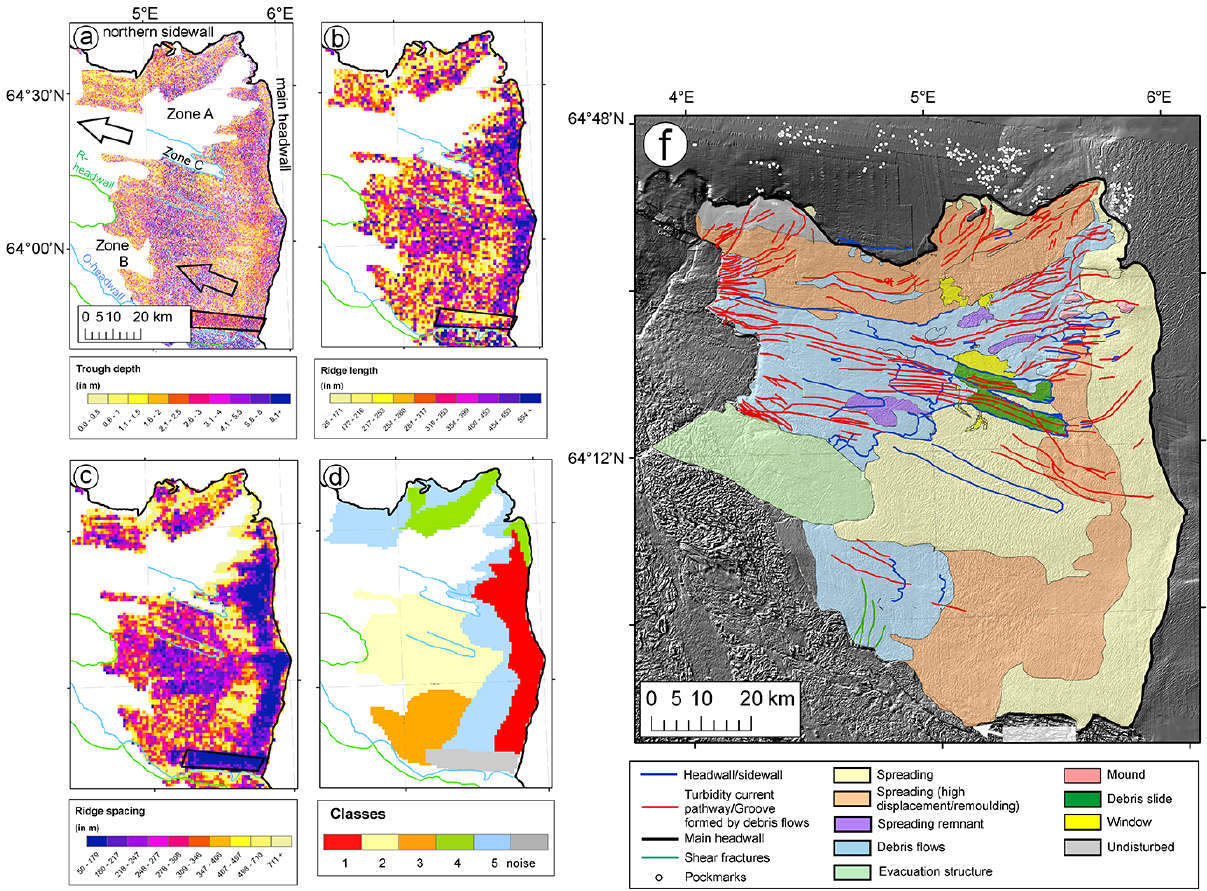
Figure 7. Example of the use of marine geomorphometry to semi-automatically map the components of mega-scale submarine landslide offshore Norway (adapted from Micallef et al., 2009). (a–c) show the trough depth, ridge length, and ridge spacing extracted from a MBES map of the north-eastern Storegga Slide using ridge characterization techniques (Micallef et al., 2007b). Figure d is a classification map generated by using these ridge characteristic maps as input layers in an unsupervised clustering algorithm (ISODATA). (e) is an interpretative map of the range of spreading events based on (a–d) . Other mass movements and geological processes and structures have been interpreted using geomorphometric mapping (Micallef et al.,